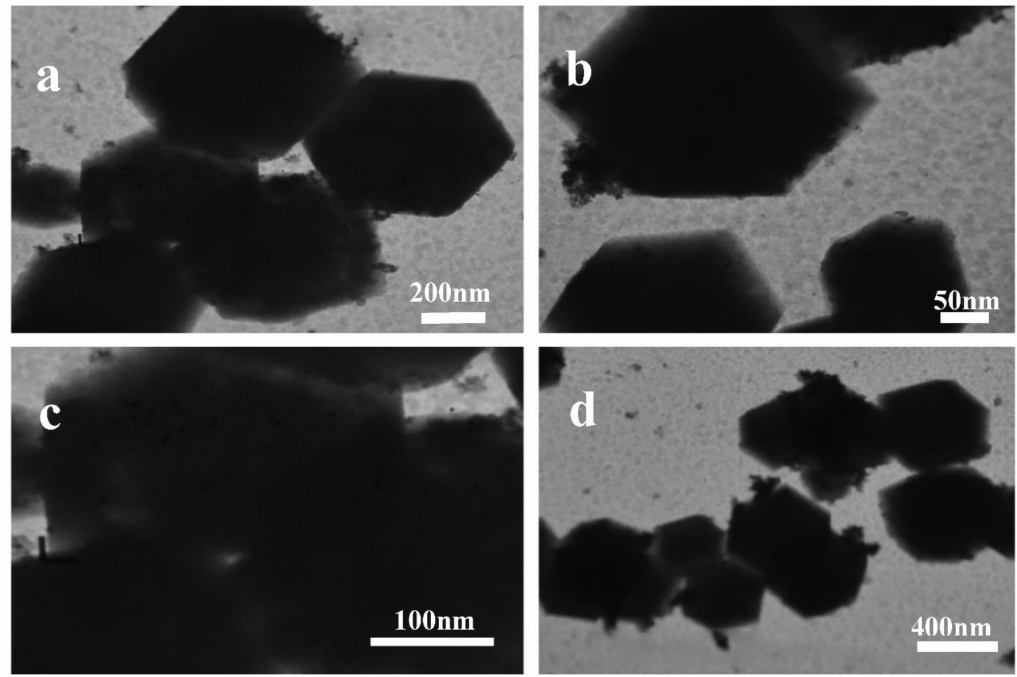
Figure 3. TEM images of ZIF-67/CeO 2 nanohybrids; ( a ) 200 nm, ( b ) 50 nm, ( c ) 100 nm, ( d ) 400 nm. The TEM images clearly display the dodecahedral morphology of ZIF-67